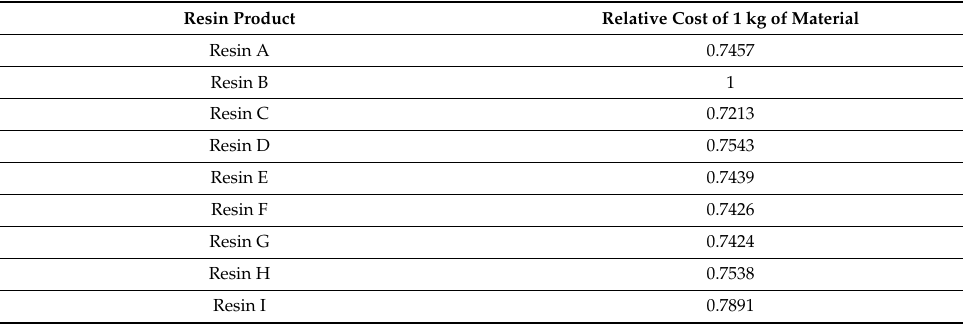
Table 2. The relative cost of 1 kg for resin products under DAP